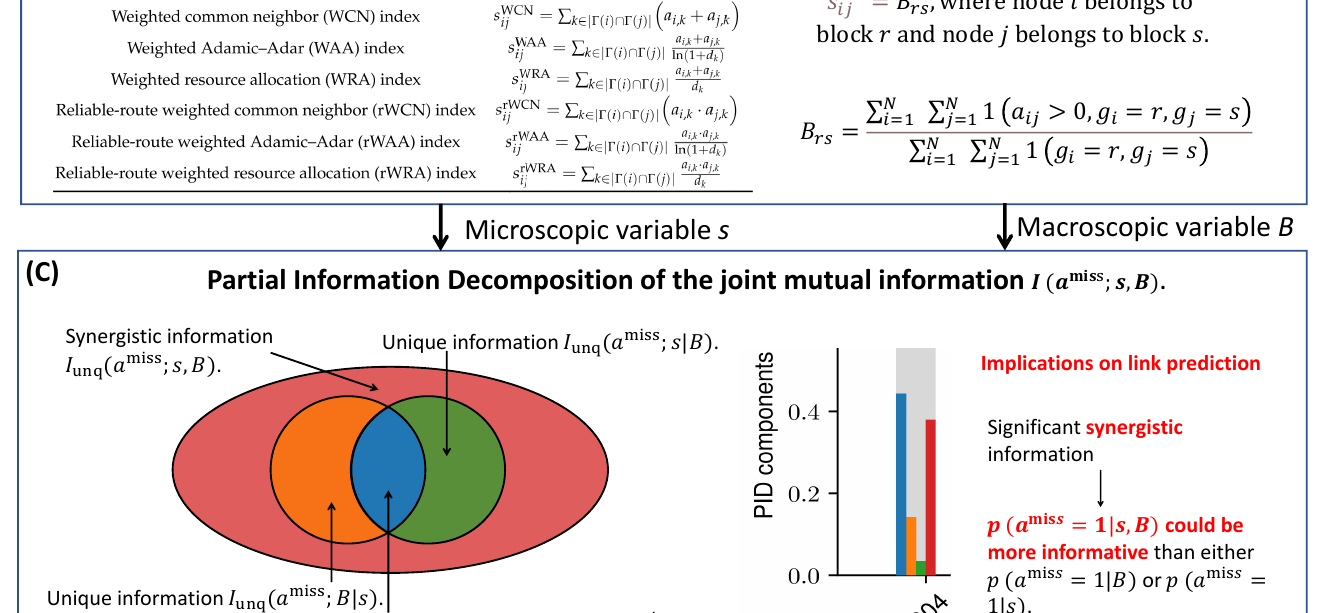
(cid:0) (cid:1) a miss ; s , B , s ) |